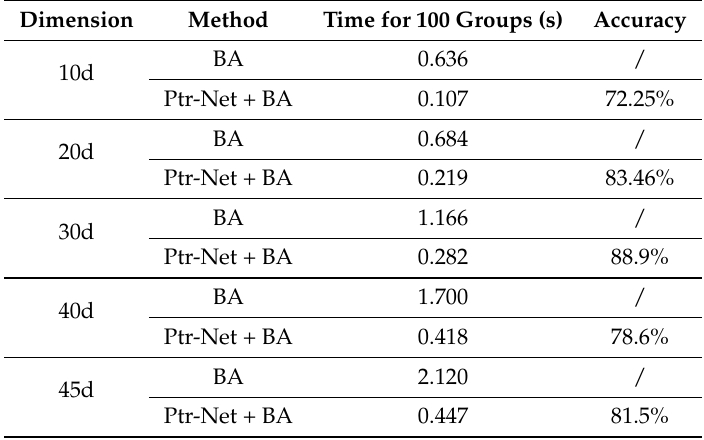
Table 2. Accuracy of results from different dimensions. Dimension Method Time for 100 Groups (s)